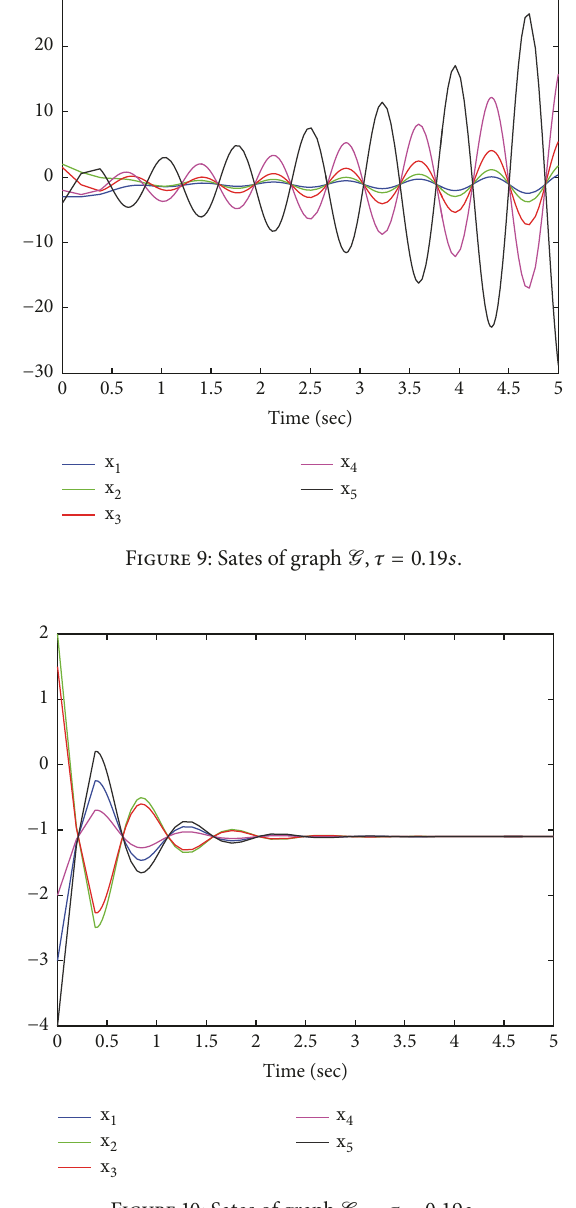
Figure 10: Sates of graph G 𝑜𝑝𝑡 , 𝜏 = 0.19𝑠 .